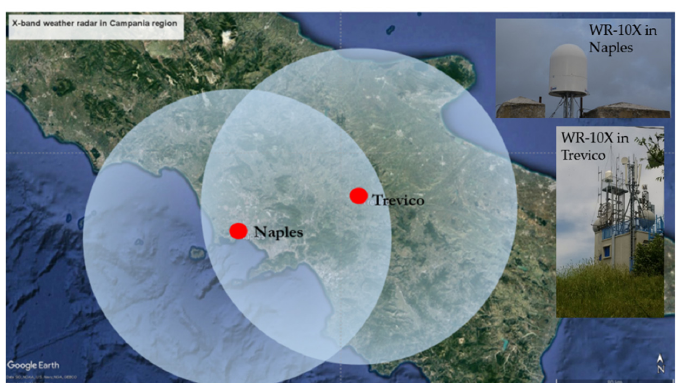
Figure 2. X-band radar network operating in the Campania Region in the framework of the CARMEN project. The filled-in red circles indicate the position of the Naples and Trevico radars. A photo of the installation facilities of the two systems, both named WR-10X, is provided by the small pictures on the right side of the figure. The coverage of both radars is highlighted by the transparent circles. Image credits: © Google Earth, Data Sio, NOAA, U.S. Navy, NGA, GEBCO.